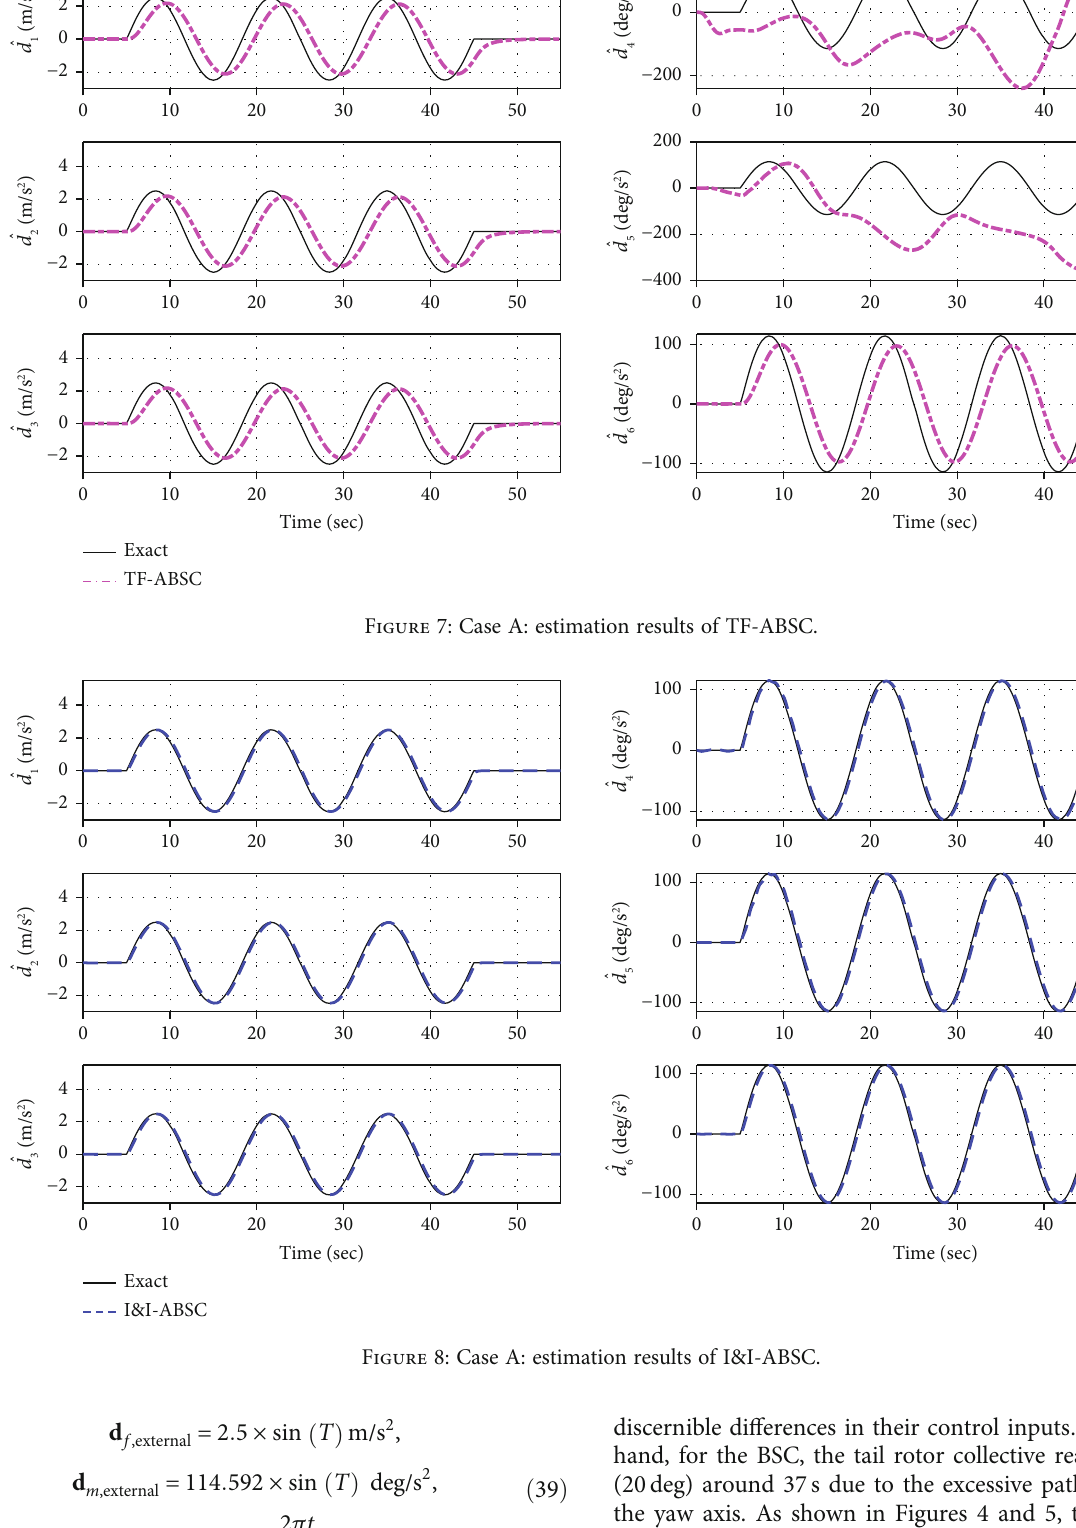
Figure 8: Case A: estimation results of I&I-ABSC.